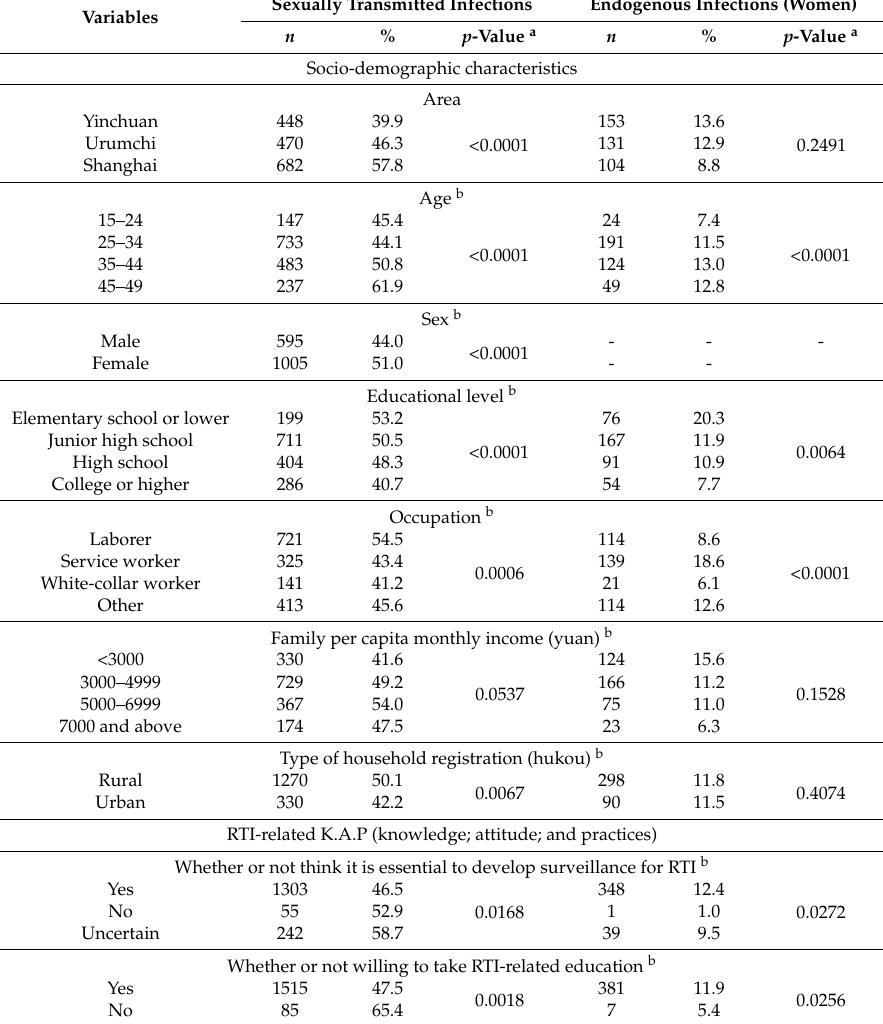
Table 5. Univariable analyses of the correlation between socio-demographic characteristics and RTIs among the internal migrant